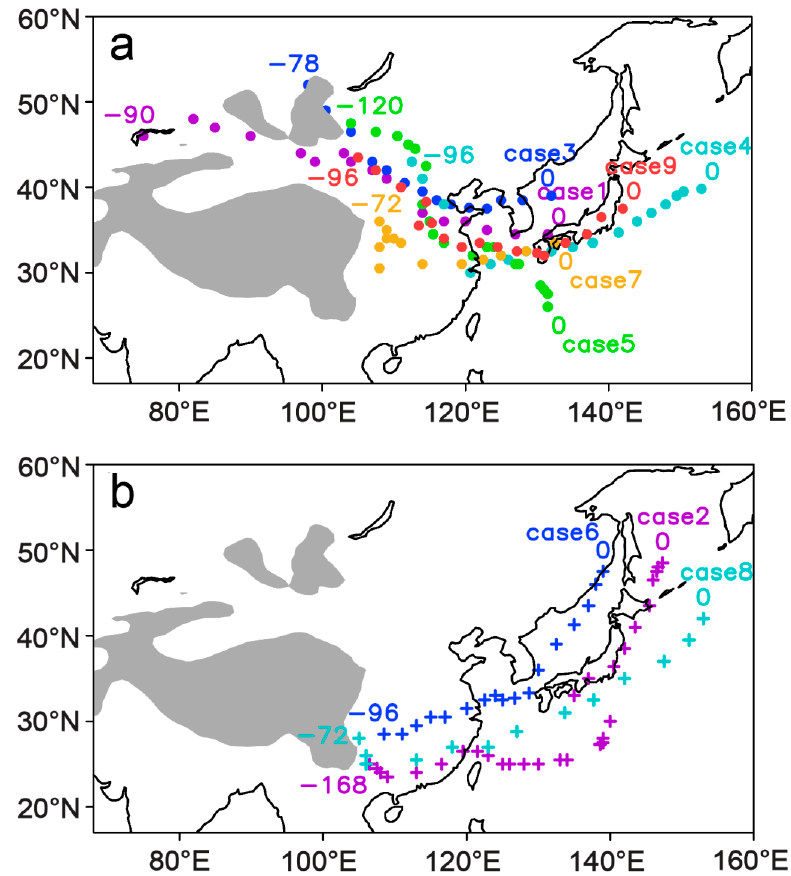
Figure 11. Motion paths ( a : southeastward; b : northeastward) of the low SSTA-GH “L1” (shown in Figure 7) for cases 1–9. The dots or pluses indicate the locations of the low SSTA-GH “L1” at 6-hour intervals, and the numbers indicate the moments (units: hours) before MCSs turned to move southeastward. The gray-shaded area are Tibetan Plateau.